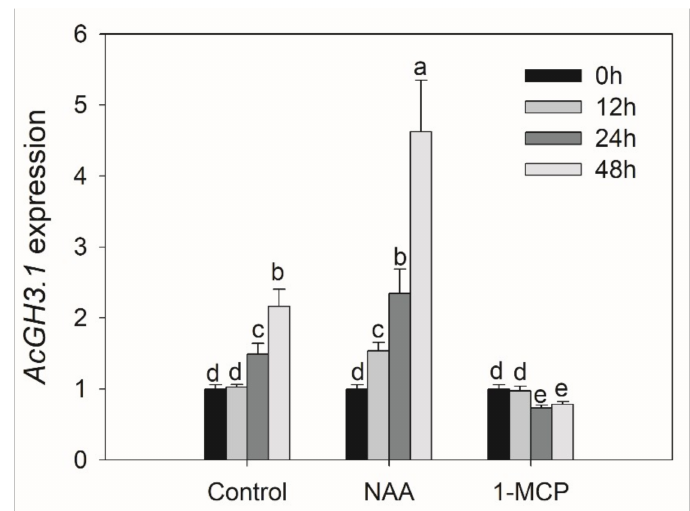
Figure 3. E ff ects of NAA and 1-MCP treatment on AcGH3.1 gene expression in fruit after harvest. All values in the figure are relative to control value 0 h after harvest. Expression of Actin was used as an internal control and to normalize the expression of AcGH3.1 gene. Error bars show the standard error between three replicates performed. Bars with the same letter are not significantly di ff erent at the 0.01 level according to a student’s t-test.